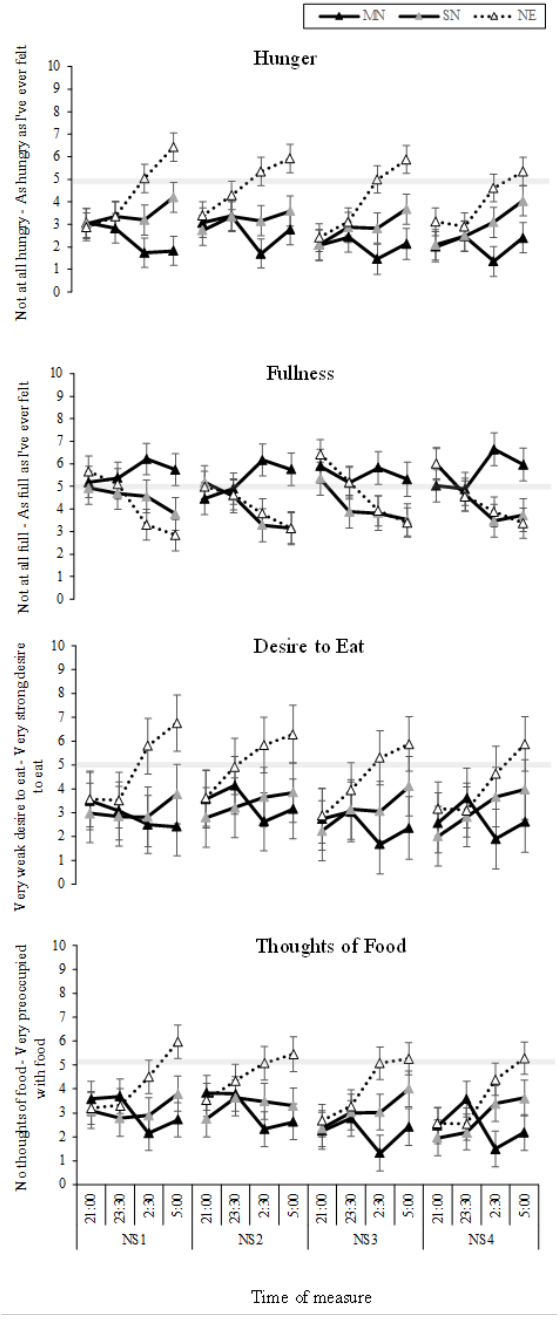
Figure 5. Food and Hunger VAS results from the interaction effect between eating condition by time of night by nightshift (NS1-4). Black lines with black markers represent the Meal at Night condition (MN), black lines with grey markers represent the Snack at Night condition (SN), dashed lines with white markers indicate the No Eating at Night condition (NE). The grey shaded horizontal line on each line graph indicates the midpoint of each VAS. Means presented are estimated marginal means, and error bars indicate standard errors from model estimates.